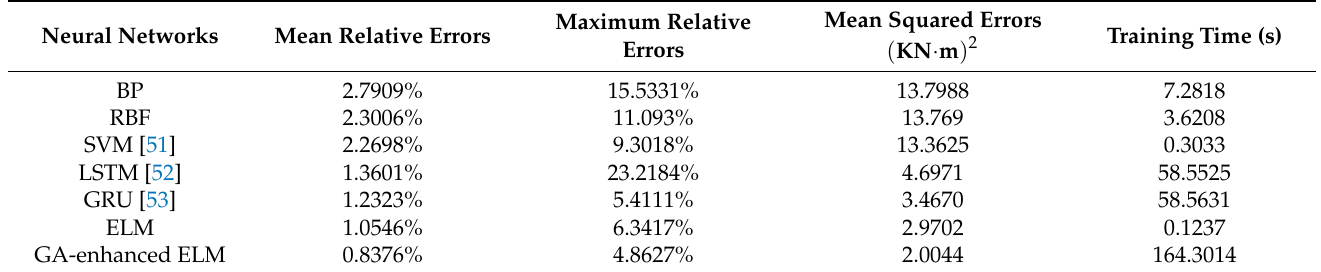
Table 5. Prediction accuracy of different neural